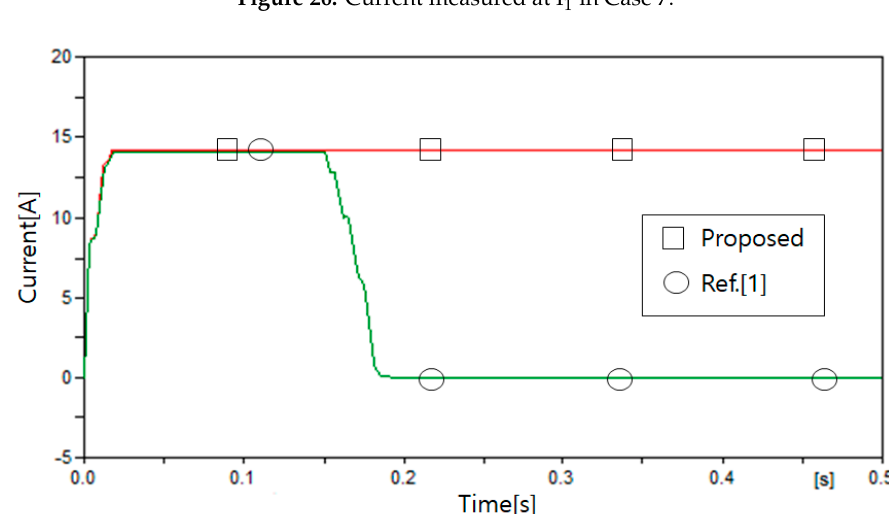
Figure 27. Current measured at Load 3 in Case 7.